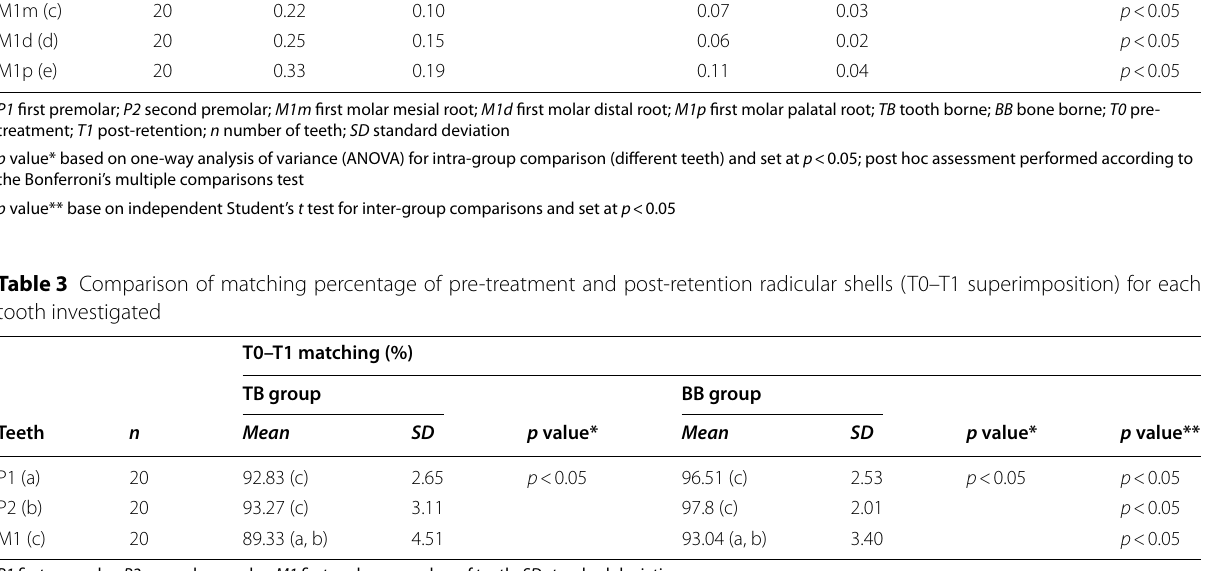
P1 first premolar; P2 second premolar; M1 first molar; n number of teeth; SD standard deviation p value* based on one-way analysis of Variance (ANOVA) for intra-group comparisons (different teeth) and set at p < 0.05 p value** for inter-group comparisons, based on independent Student’s t test and set at p <